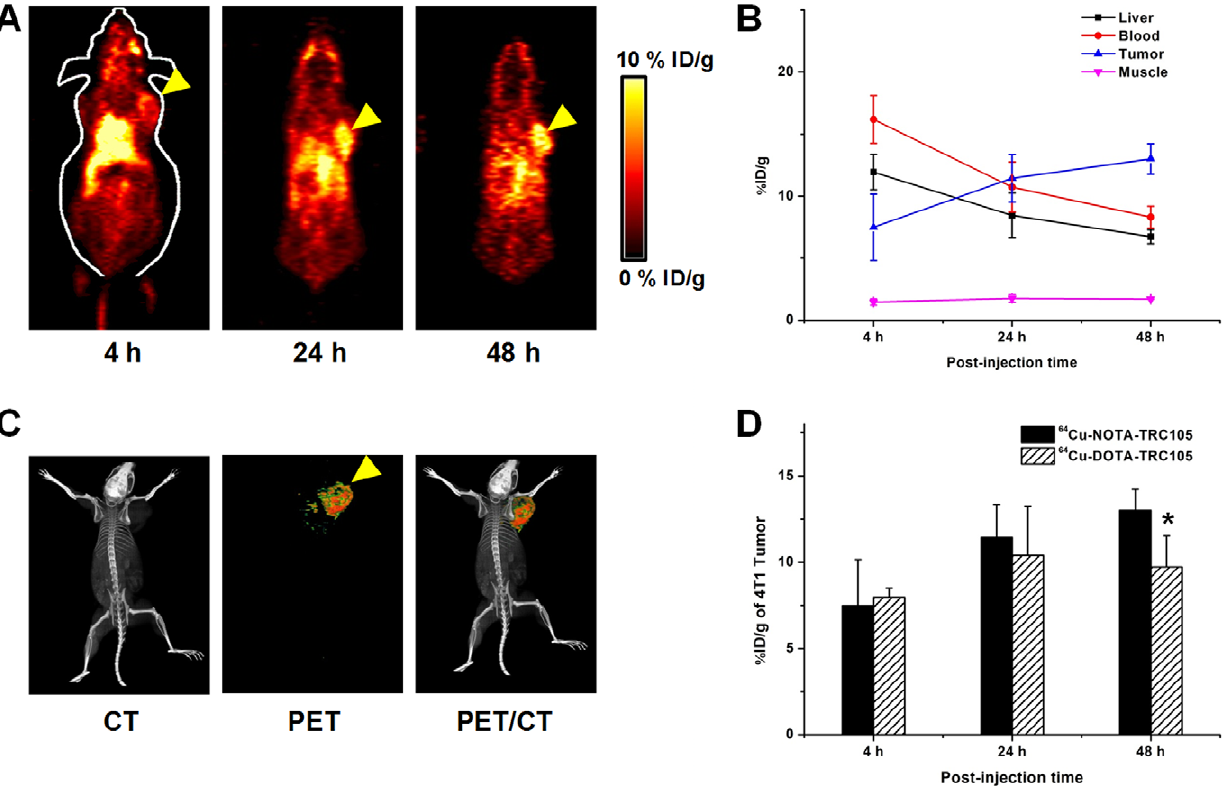
Figure 3. Small animal PET imaging of 4T1 tumor-bearing mice. A. Serial coronal PET images at 4, 24, and 48 h post-injection of 64 Cu-NOTA- TRC105. Tumors are indicated by arrowheads. B. Time-activity curves of tumor, liver, blood, and muscle after intravenous injection of 64 Cu-NOTA- TRC105 into 4T1 tumor-bearing mice (n=3) C. Representative PET/CT images of 64 Cu-NOTA-TRC105 in 4T1 tumor-bearing mice at 48 h post- injection. D. Comparison of the 4T1 tumor uptake of 64 Cu-NOTA-TRC105 and 64 Cu-DOTA-TRC105. *: P ,